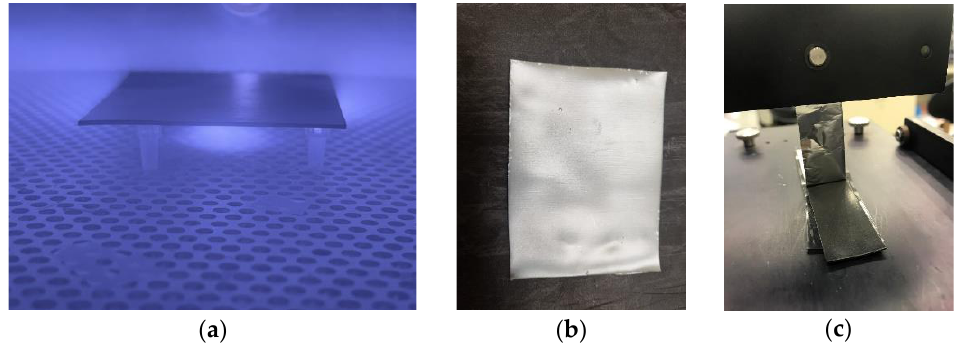
Figure 1. HDPE/Wax/EG Al laminate preparation and adhesion analysis: ( a ) Plasma treatment of HDPE/Wax/EG; ( b ) Prepared laminate; ( c ) Peel test.